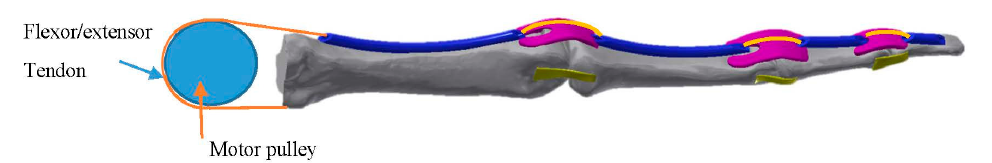
Figure 4. Mechanical architecture of the tendon transmission.